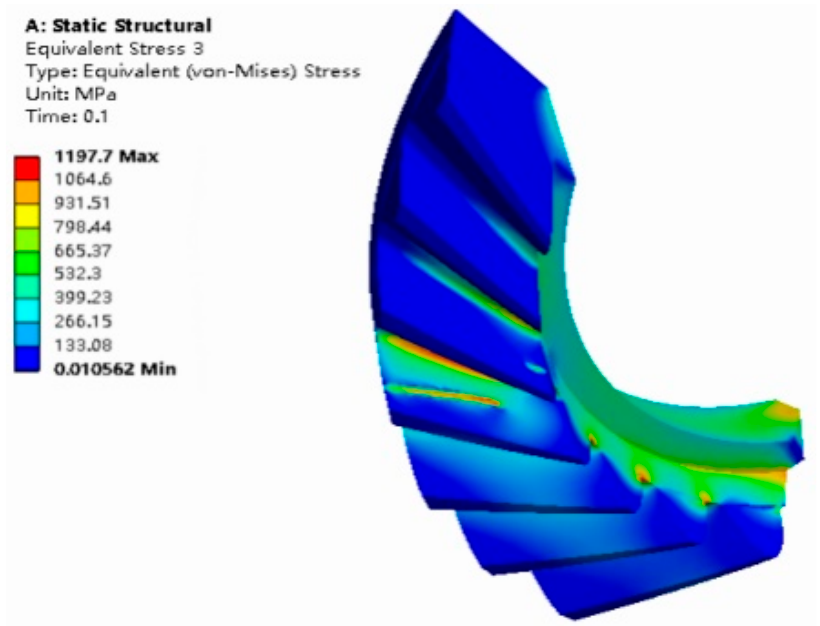
Figure 5. Stress distribution nephogram of the driven gear.